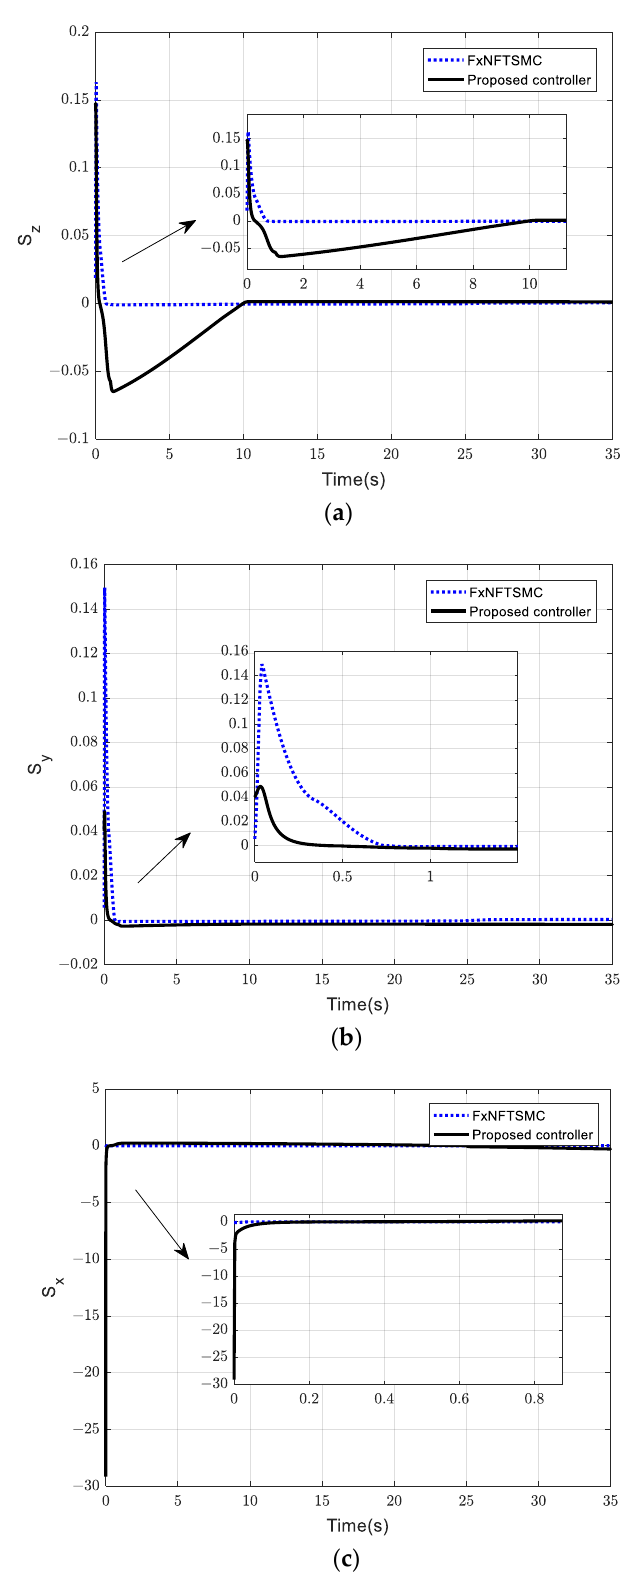
Figure 7. Sliding mode surface of three channels: ( a ) the roll channel; ( b ) the yaw channel; ( c ) the pitch channel.